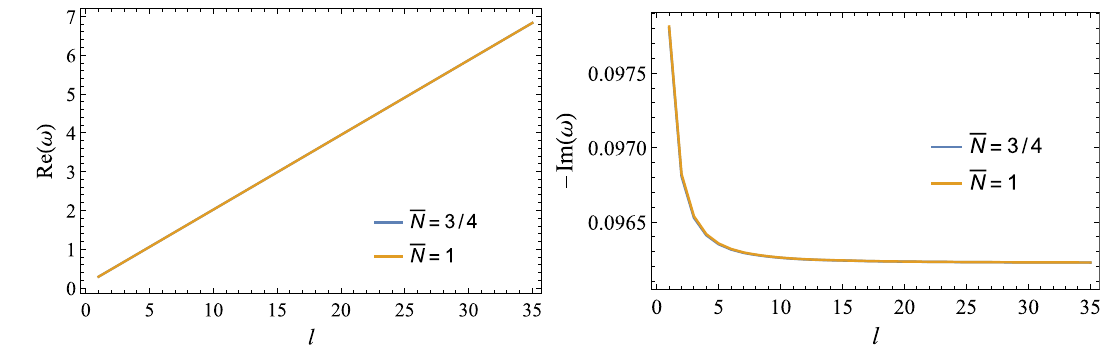
Fig. 16 QNMs of CRSBHs with respect to l , where ¯ L = 0 . 45 and n = 0 are set. The left diagram represents the real parts of ω with respect to l for the cases of ¯ N = 3 / 4 and ¯ N = 1, respectively; the right